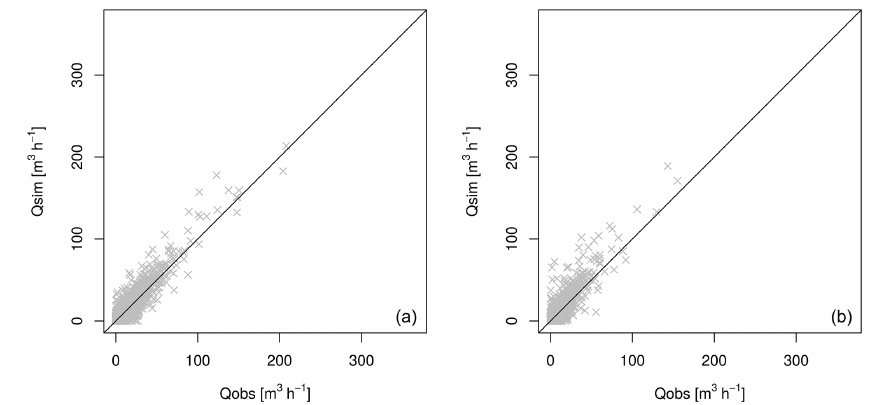
Figure 10. Comparison of simulated and observed total stormwater sewer discharge (m − 3 h − 1 ) during (a) the first simulation period from September 1993 to August 1995 (left side), and (b) the second simulation period from September 1995 to August 1997 (right side) for simulation 13 and a deep drainage limited to 2%.